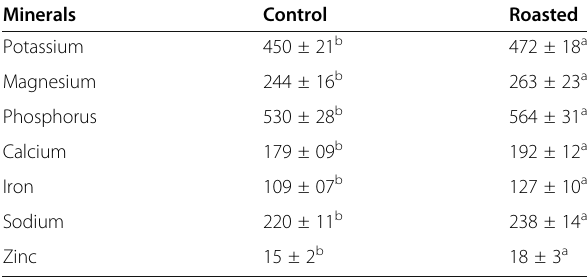
Table 2 Mineral profile of both control (unroasted) and roasted fox nuts ( μ g g − 1 on d.w. basis) Minerals